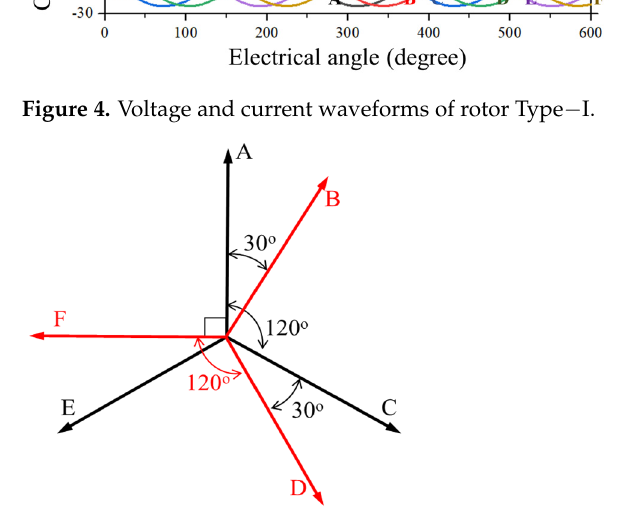
Figure 5. Phase vectors of the six-phase winding arrangement.